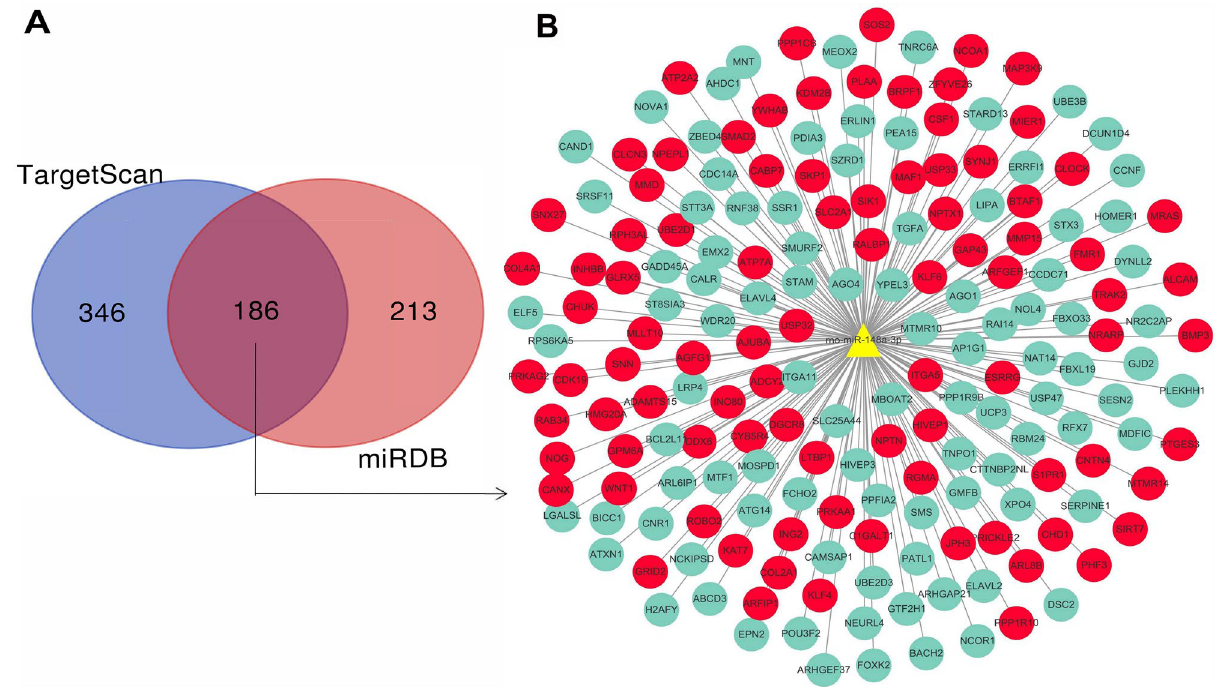
Figure 2. MiR-148a-3p target gene analysis. ( A ) Venn diagram of target genes for candidate miRNAs. ( B ) miR-148a-3p target gene network. Each node represents a target gene. Among them, red nodes represent genes related to nerve, immune and epigenetic pathways. Green nodes represent genes with other functions (development, gene transcription,